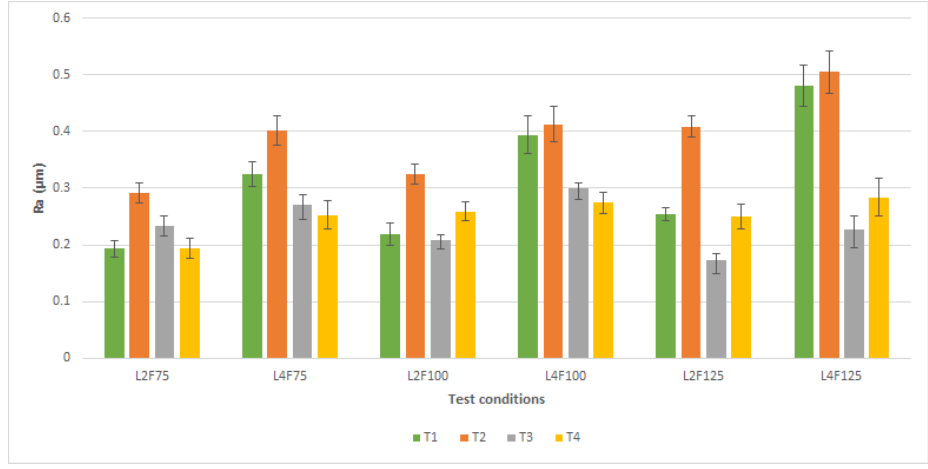
Figure 19. Average values of Ra, measured in the radial direction, produced by T1, T2, T3 and T4 tools for all the different test conditions.